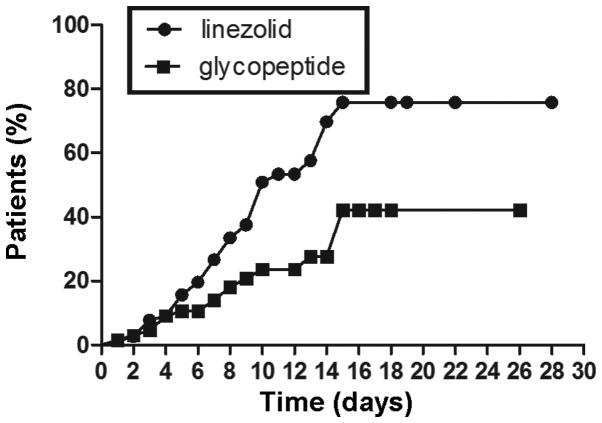
Kaplan-Meier plot of the probability of the number of platelets being <100×109/l in patients aged ≥65 years. Log rank test P=0.002.